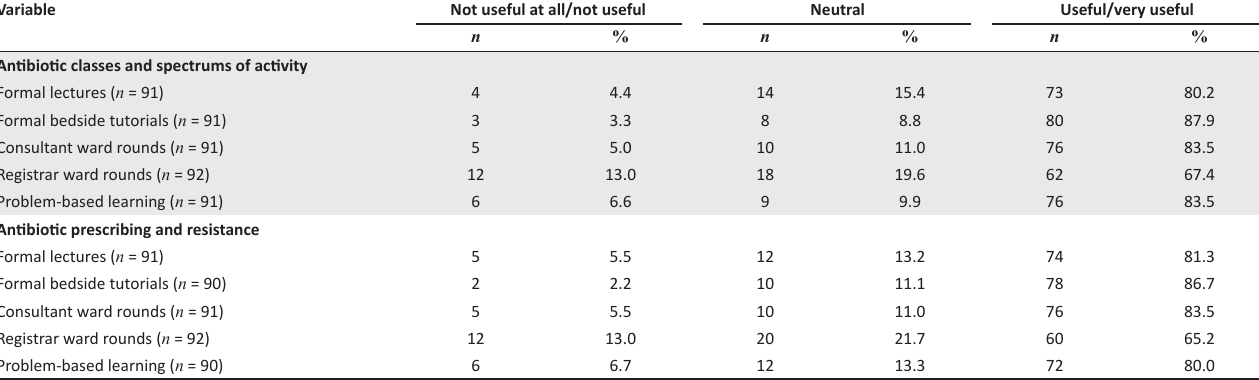
TABLE 3: Perceptions of the respondents regarding the usefulness of different educational methods in the medical curriculum. Variable Not useful at all/not useful Neutral Useful/very